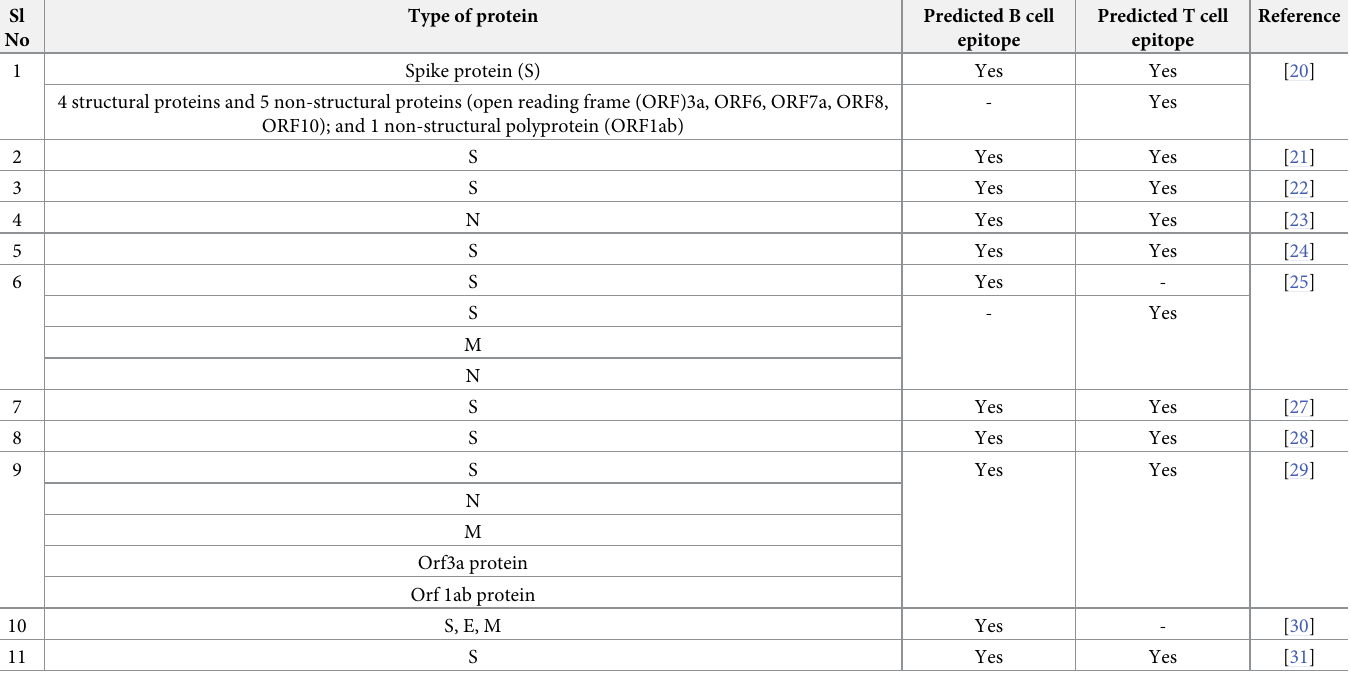
Table 1. A summary of literature review showing the bioinformatically predicted B- and T-cell epitopes identified in the structural proteins of SARS-CoV-2. Sl No